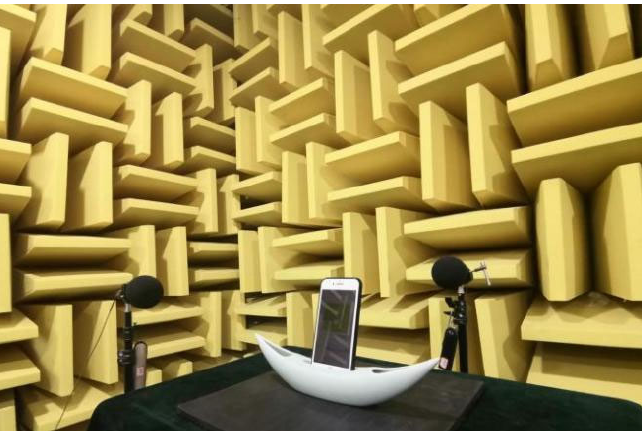
Figure 4. Actual shot of experimental scene (sample 9).